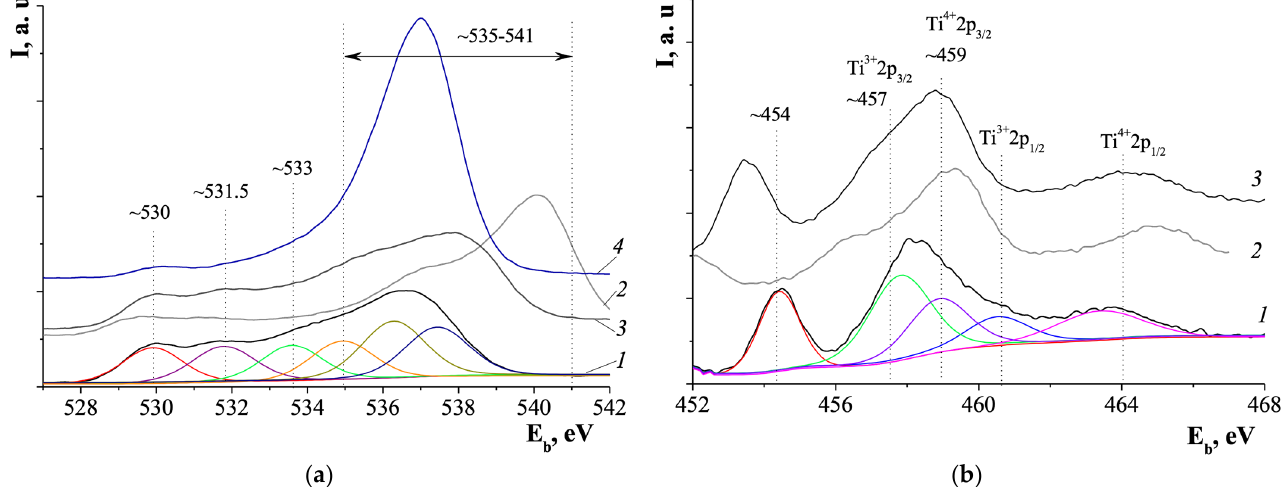
Figure 11. O2s core-level ( a ) and Ti2p core-level ( b ) X-ray photoelectron spectra of samples: NA:Ni/HZSM(40)-3 (1), NA:V/HZSM(40)-3 (2), NA:Ag/HZSM(40)-3 (3) and HZSM(40) (4) (adapted from [65]).